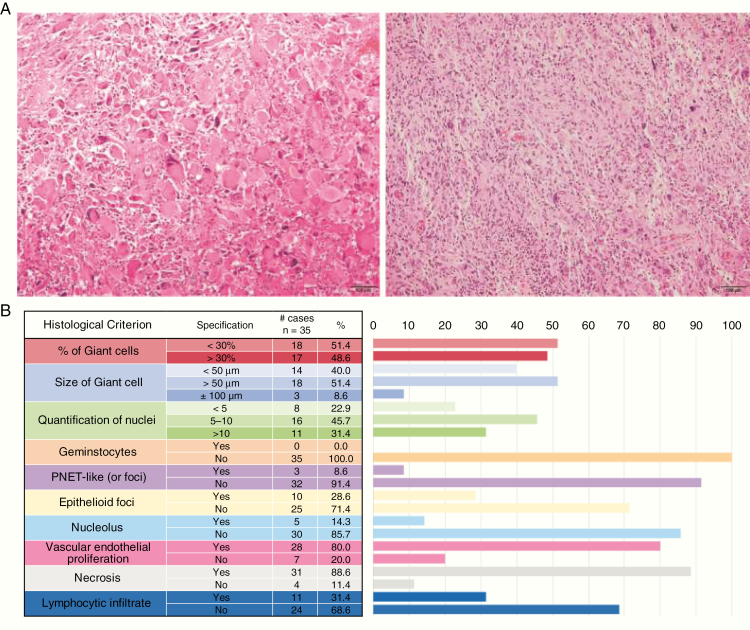
Histological evaluation of the tumors. (A) Photomicrographs of tumor tissue sections stained with hematoxylin and eosin showing multinucleated giant cell morphology. Left, a giant cell glioblastoma (gcGBM) tumor classified as having more than 30% giant cells. Right, a GBM tumor containing less than 30% giant cells. (B) Summary of the results obtained after histological reevaluation of the cases.